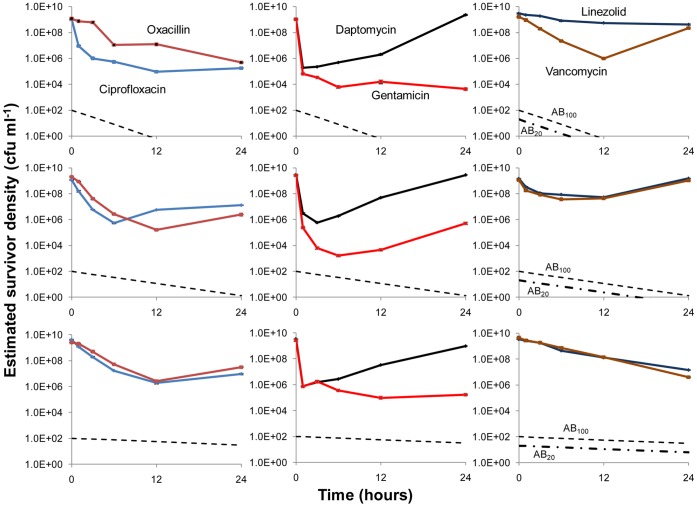
Changes in viable cell density and theoretically predicted antibiotic concentrations in antibiotic-treated continuous cultures maintained at three different dilution rates: Fast w ∼ 0.4 (top row); moderate w ∼ 0.2 (middle row); and slow, w ∼ 0.04 (bottom row) upon treatment with single antibiotic doses added at time 0.Save for linezolid, which because of its lower solubility was added at 20× the MIC, the initial concentration of the antibiotics were approximately 100× MIC. The changes in the concentrations of the antibiotics in these figures, the broken lines, are calculated from equation (1) under the assumption that these concentrations decline exponentially at rates equal to that of flow.